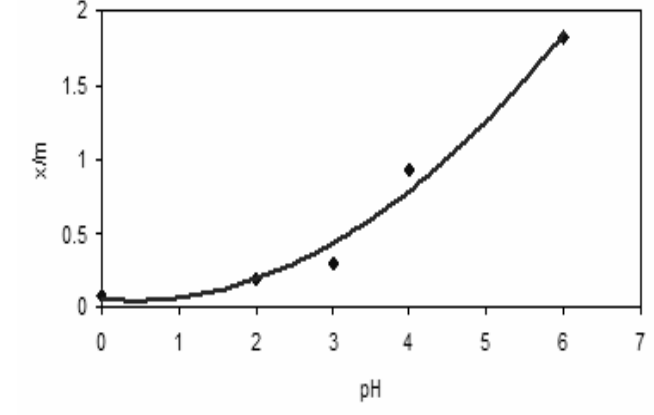
Figure 13 . Effect of pH on Pb 2+ sorption by PANi/SD